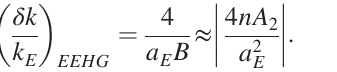
FIG. 6. Harmonic bunching bandwidth as a function of quadratic chirp. Same parameters as Fig. 5.